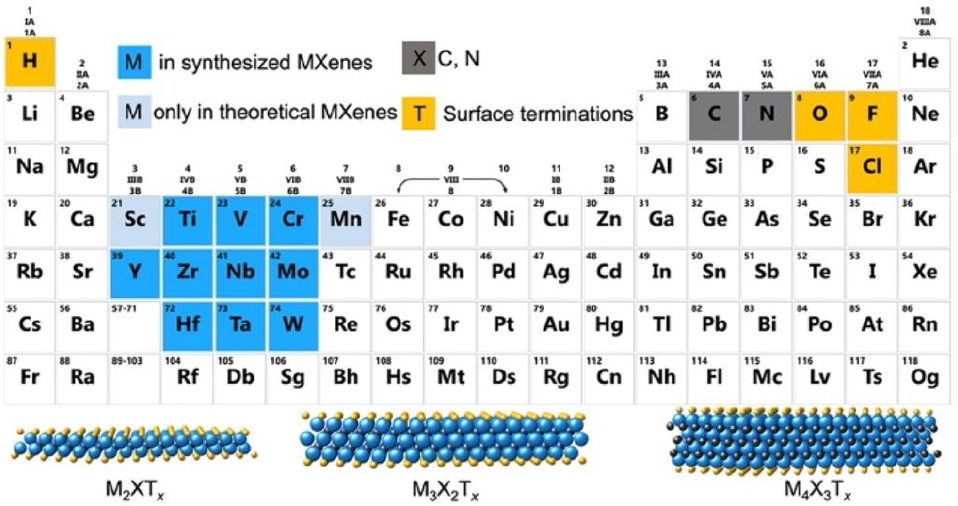
Figure 2. Periodic table showing compositions of MXenes, MAX phases, and corresponding elements used to build MXenes. (Reprinted with permission from Ref. [34]. Copyright 2011 American Chemical Society).